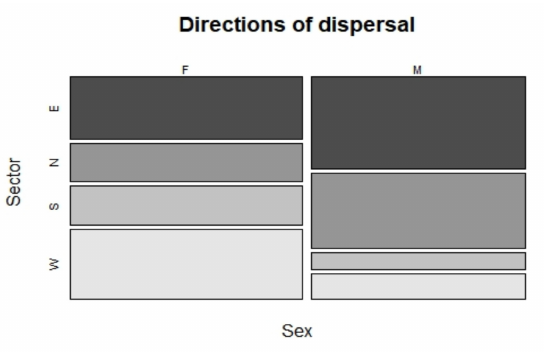
Figure 4. Mosaic plot of the frequency of wolves dispersing in each directional sector by sexes. Sectors are defined as follows: 316 ◦ –45 ◦ (N), 46 ◦ –135 ◦ (E), 136 ◦ –225 ◦ (S), 226 ◦ –315 ◦